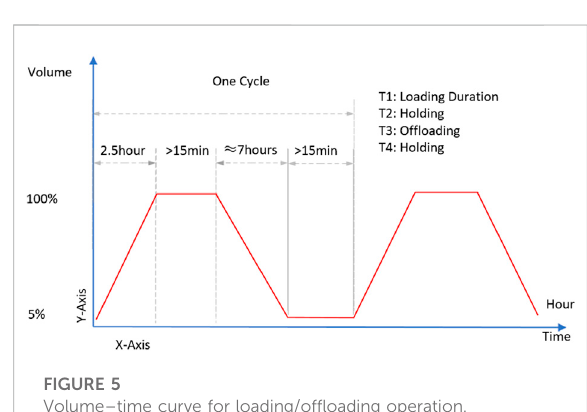
FIGURE 4 Test set-up for the 1.7-m prototype.